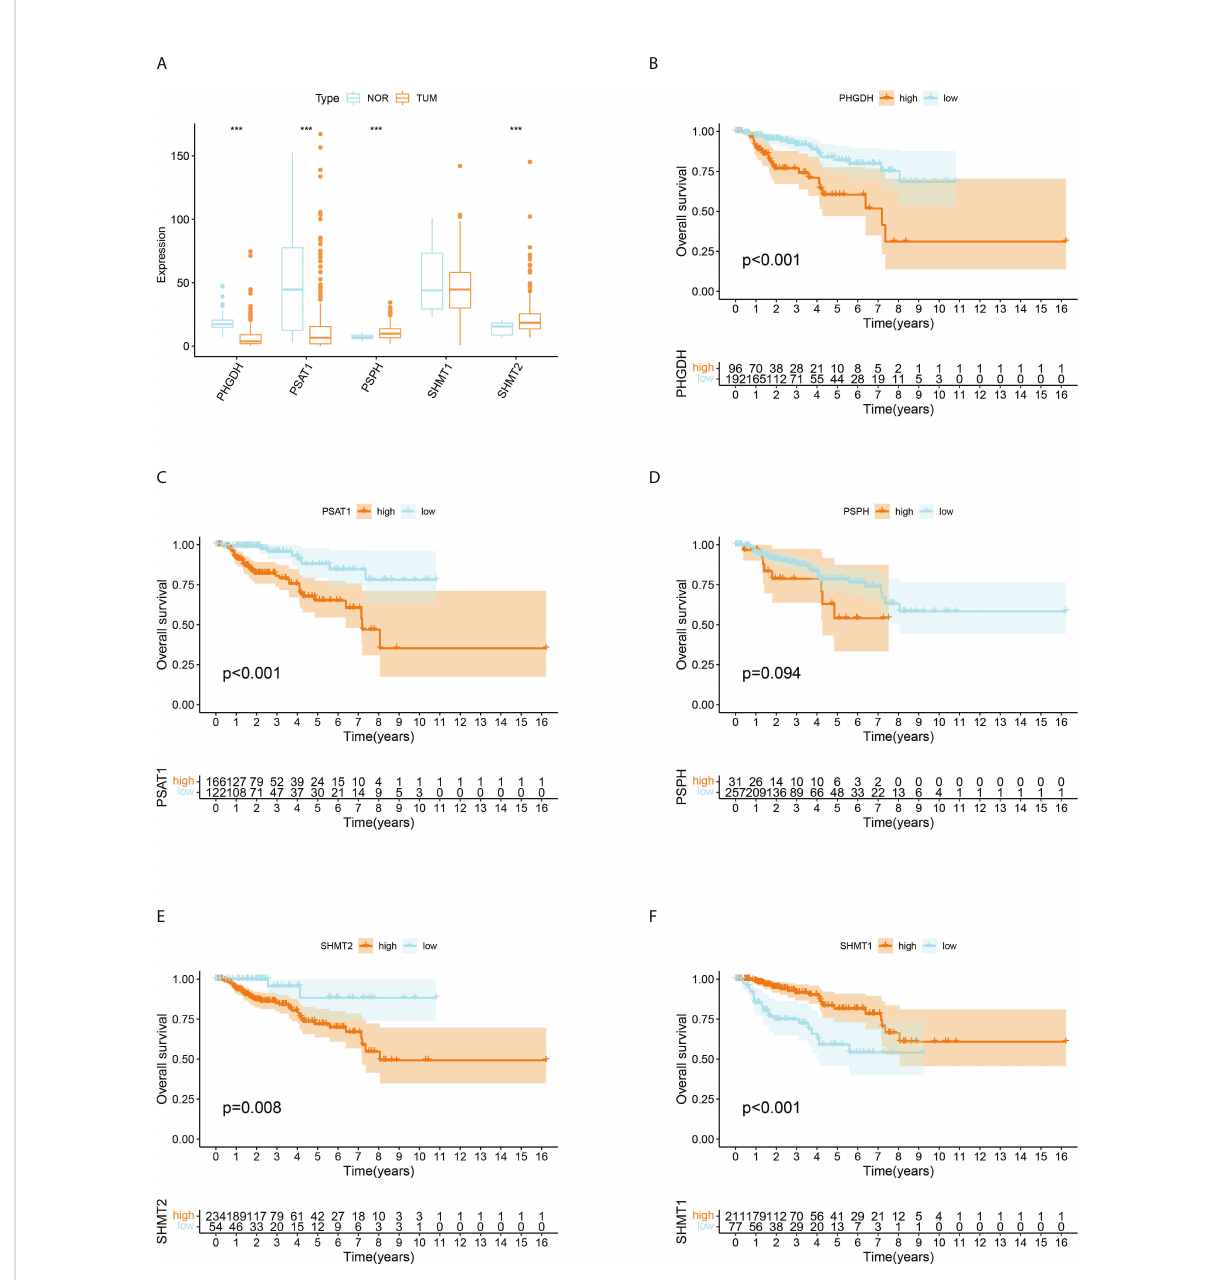
FIGURE 1 Differentially expressed serine metabolic genes (SMGs) in papillary renal cell carcinoma (pRCC) and normal tissues and their relationship with prognosis. (A) The expression pro fi les of SMGs in pRCC and normal tissues. Yellow, tumour; blue, normal. The upper and lower ends of the boxes represent the interquartile ranges, and the lines in the boxes represent the median values. Adjusted p < 0.05 and |log2 fold changes (FC)| > 1.5 were used as the criteria for screening differentially expressed SMGs; *p < 0.05, **p < 0.01, and ***p < 0.001. (B – F) Survival analyses for each differentially expressed SMG based on 289 patients with pRCC from TCGA cohorts. Kaplan – Meier curves with log-rank p < 0.05 showed a signi fi cant survival difference between the high expression and low expression groups. The shaded area represents the 95% con fi dence